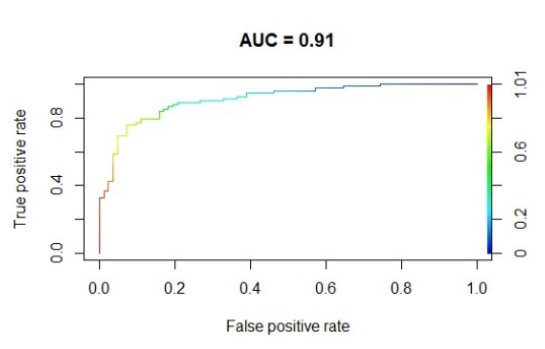
Figure 6: ROC curve of the LR